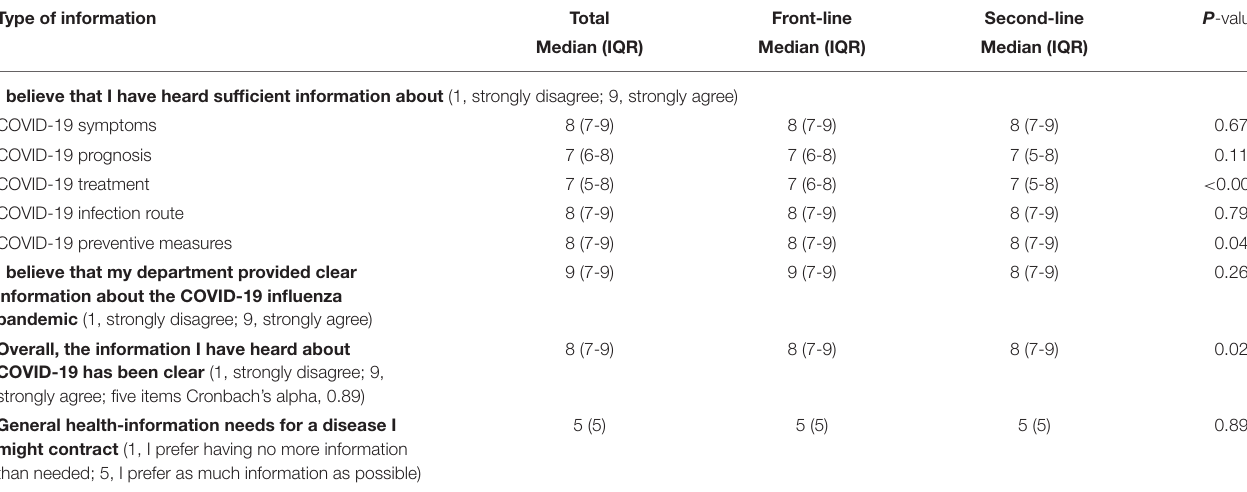
TABLE 5 | Perceived sufficiency of information about the COVID-19 pandemic and general health information needs. Type of information Total